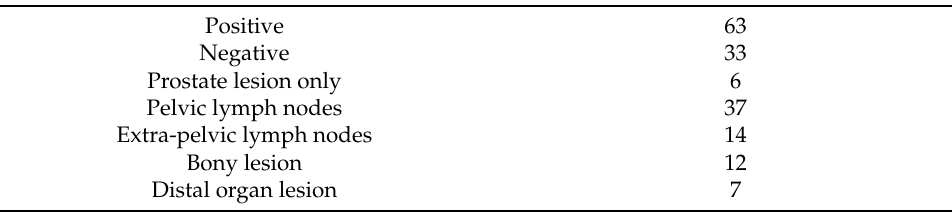
Table 2. PSMA PET-CT results.